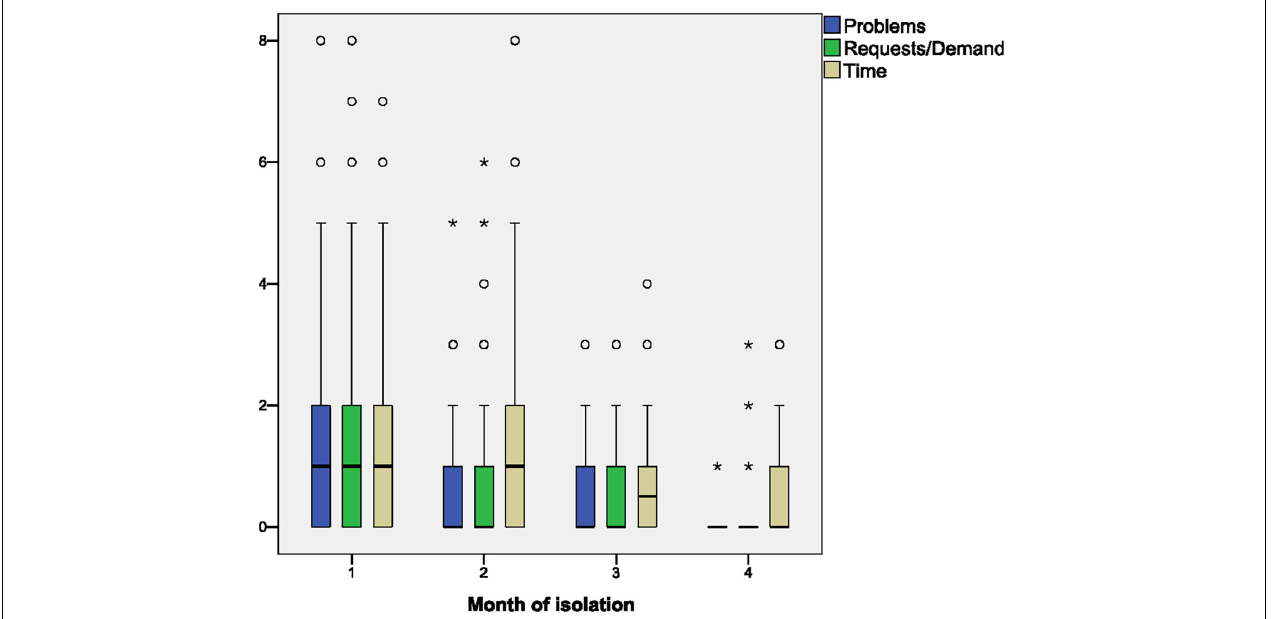
FIGURE 2 | Monthly dynamics of the average daily number of statements in the “problems,” “requests,” and “time” categories in crew communication with the mission control center (MCC). Circles and asterisks indicate, respectively, outliers and extreme outliers (significantly different values on some days of the isolation, according to SPSS statistical